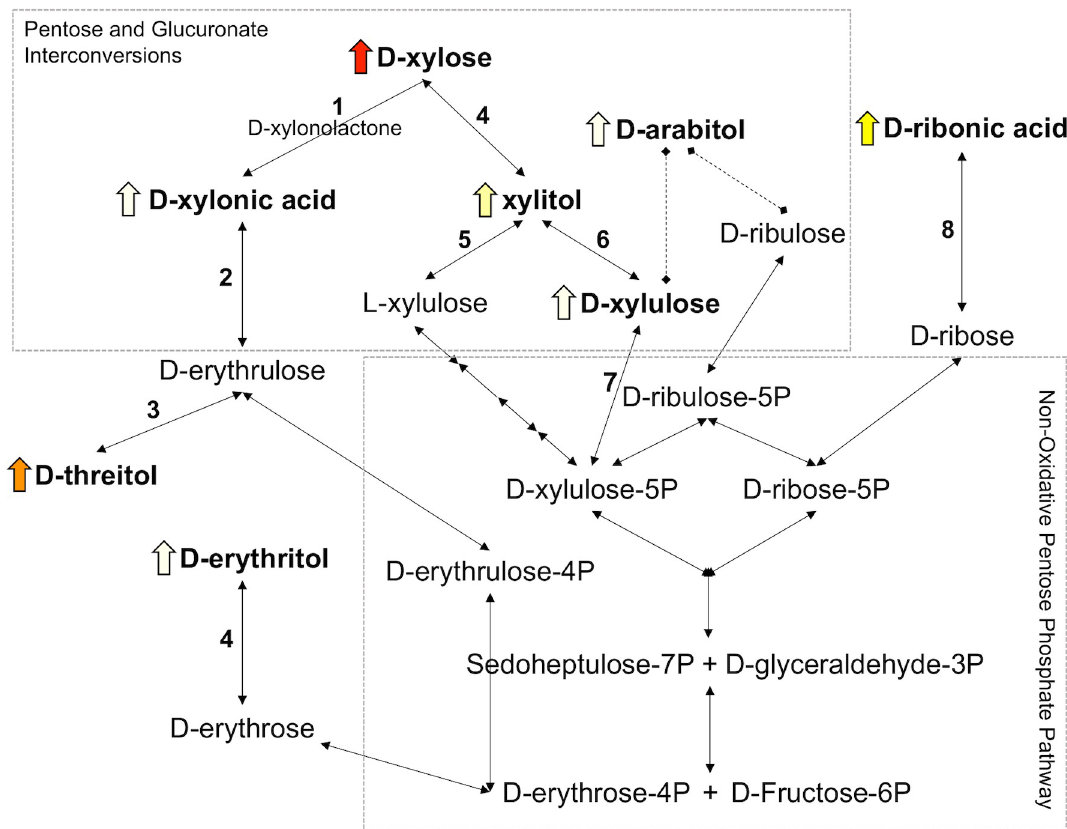
Fig 2. Proposed xylose metabolic pathway. Dietary D-xylose concentration (0, 2, 4, or 8%) linearly increased the urinary excretion of the compounds in bold font ( P < 0.0001). Non-bolded compounds were not detected in urine samples. The color of the block arrow indicates average excretion amount of the compound in pigs from the 8% xylose treatment; red: 40 g/d, orange: 13 g/d, yellow: 0.3 g/d, white: < 0.2 g/d. Solid connecting arrows represent reactions confirmed in mammals and dashed connecting lines represent presumed reactions based on reactions occurring in microorganisms. Highlighted enzymes: 1) D-xylose 1-dehydrogenase (1.1.1.179), 2) L-gulonate 3-dehydrogenase (1.1.1.45), 3) D-erythrulose reductase (1.1.1.162), 4) aldose/aldehyde reductase (1.1.1.21), 5) L-xylulose reductase (1.1.1.10), 6) xylitol dehydrogenase (1.1.1.14), 7) xylulokinase (2.7.1.17), and 8) D-ribose dehydrogenase (1.1.1.115). The boxes indicate KEGG metabolic pathway classifications [36].